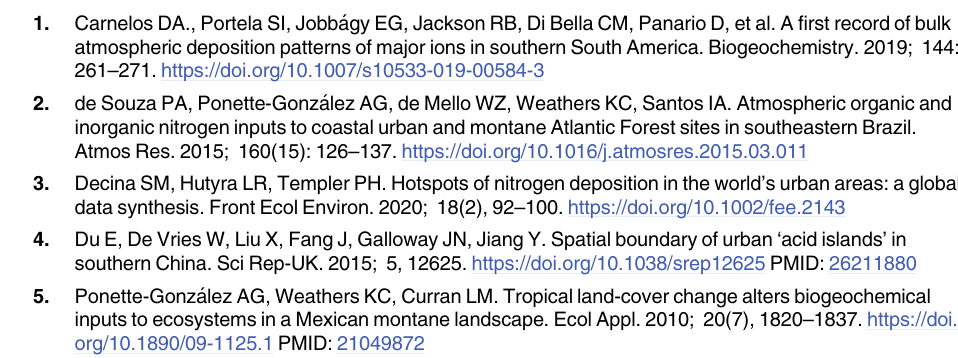
S1 Fig. Nitrogen deposition rates per collection period for both samplers at each of the six urban sites sampled in the Dallas-Fort Worth metropolitan area from April 2014 to Octo- ber